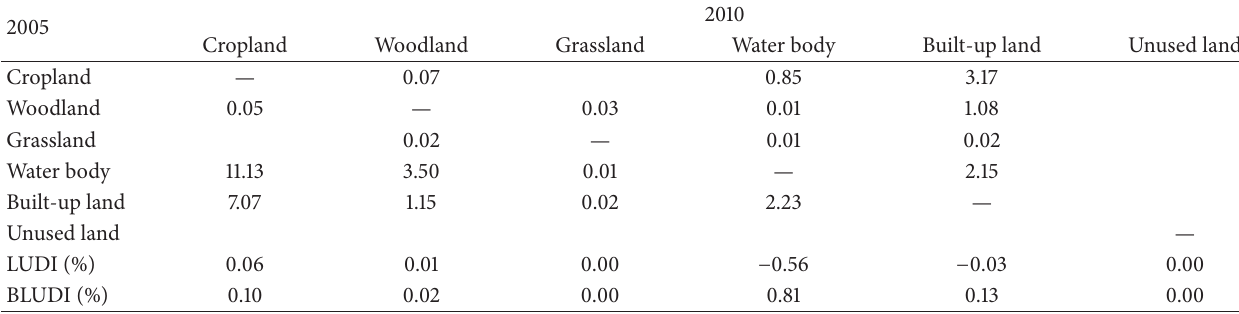
Table 4: Land use change detection matrix in the period of 2005–2010 (km 2